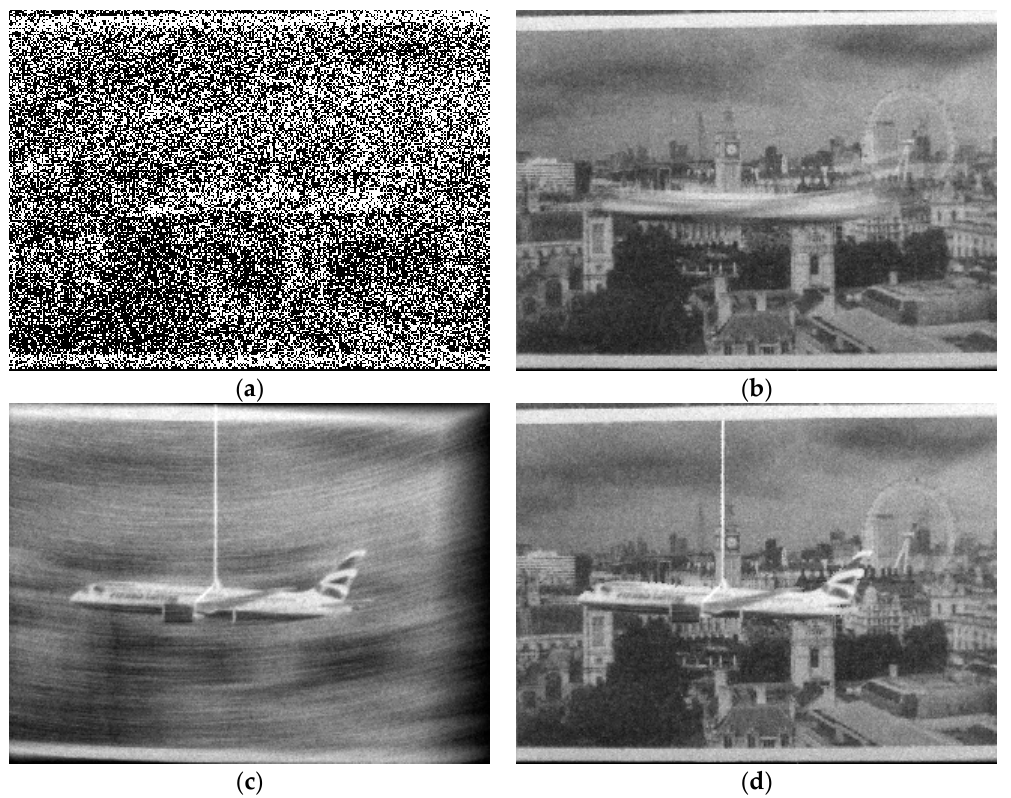
Figure A1. Results of plane test: ( a ) single raw bit-plane (100 µs); ( b ) sum of N = 250 bit-planes (still frame from video rate image sequence) ( c ) reconstructed image of plane (from N = 250 bit-planes); ( d ) image frame from final output sequence obtained using tracking scheme. A cubicle of { N x , N y , N t } = {8, 8, 32} was applied to create the test frames (not shown here), and difference frames were computed with d = 2.